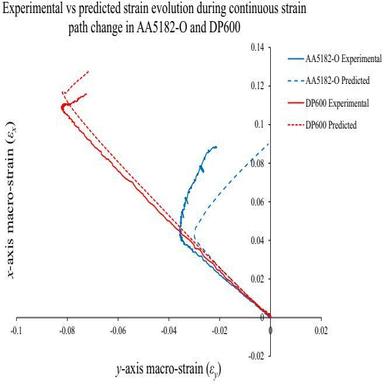
Experimental vs predicted average strain evolution during continuous strain path change at the central thinned region in AA5182-O and DP600 samples.